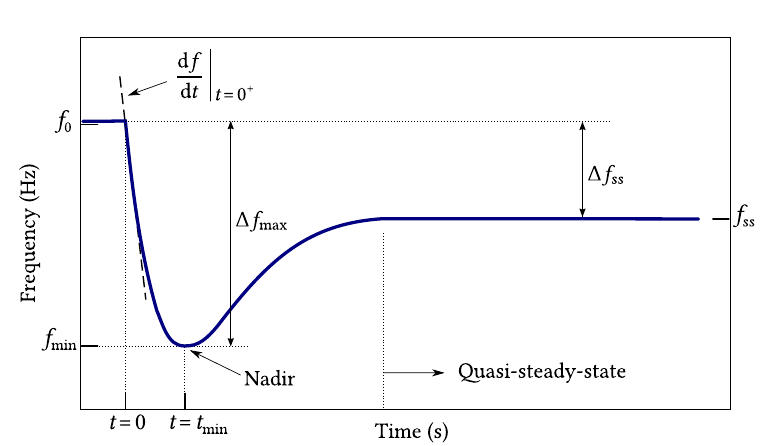
Figure 5. System frequency response considering primary